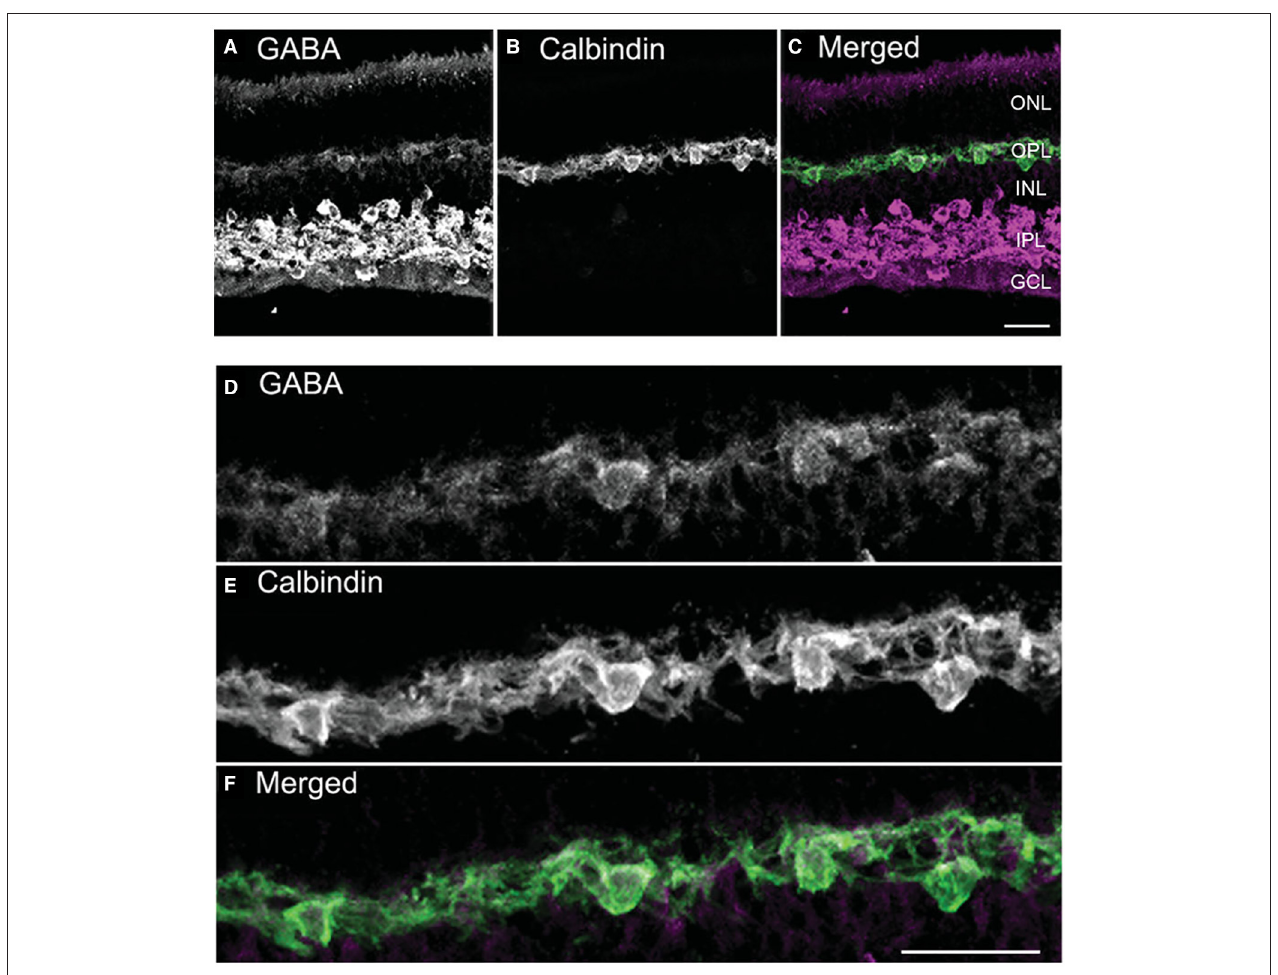
FIGURE 1 | GABA immunoreactivity is localized to horizontal cell bodies and their processes. (A–C) A vertical section through the guinea pig retina was double labeled with antibodies to GABA (A) and calbindin-28K (calbindin, B ). Weak, yet distinct, GABA immunolabeling occurs in the outer retina, in contrast to the strong GABA immunolabeling distributed to amacrine cell and displaced amacrine cell bodies and processes in the inner plexiform layer (IPL). (C) Merged image shows the co-localization in horizontal cell bodies and processes. (D–F) Higher magnification views of the outer plexiform layer (OPL) show the GABA immunoreactivity (D) in the calbindin-identified horizontal cells (E) in the merged image (F) . Images are maximum intensity projections of 6 optical sections, z = 5 µ m. Scale bar, 20 µ m in C (applies to A–C ), (F) (applies to D–F ). ONL, outer nuclear layer; INL, inner nuclear layer; GCL, ganglion cell layer. [Modified from ( Guo et al.,